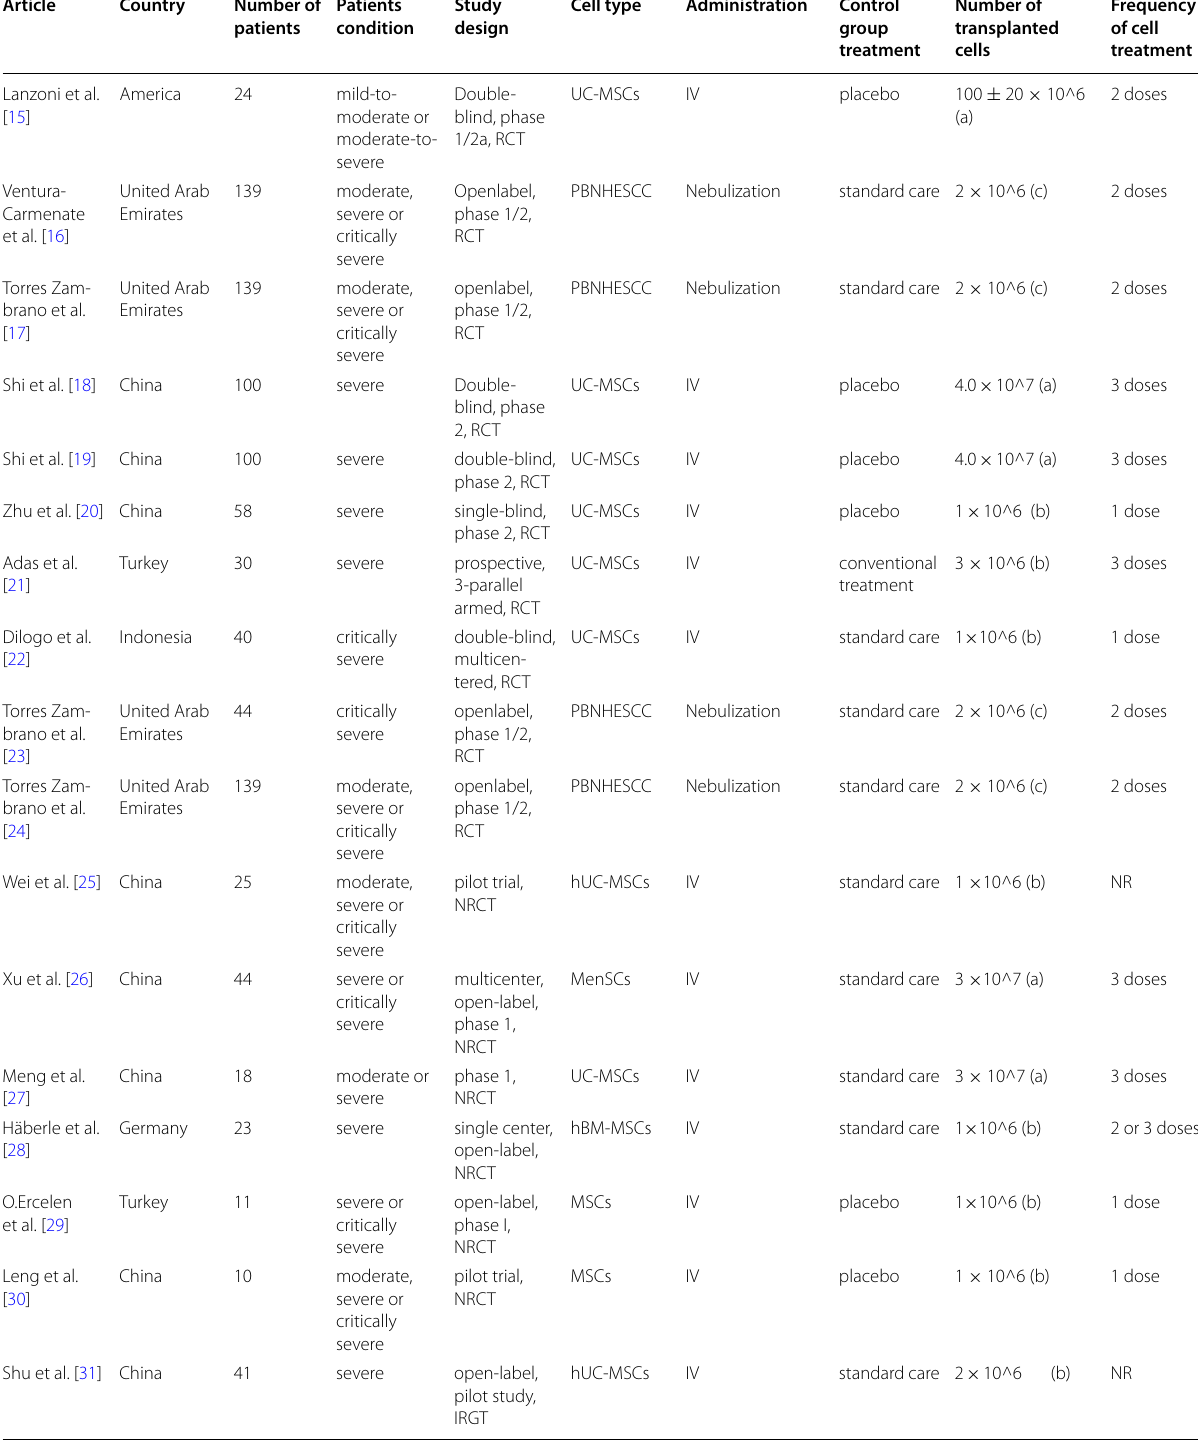
Table 1 Clinical and study